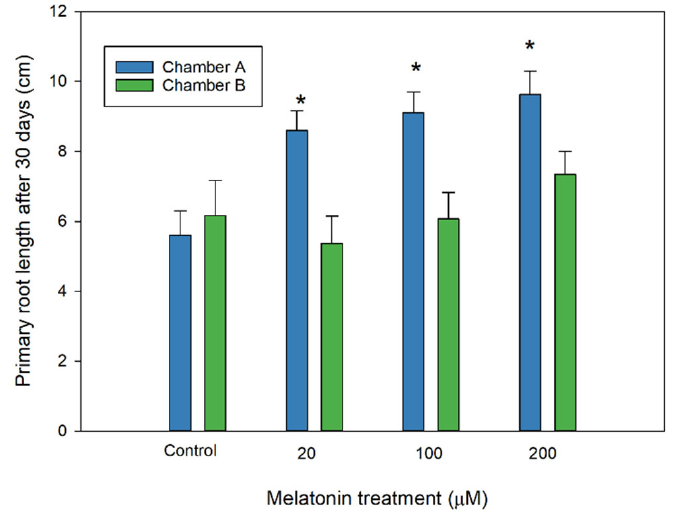
Figure 3. Effect of melatonin in almond primary root length of primed seeds after 30 days in chamber A and B (see Table 1). Each bar represents the mean value ( n = 36) ± SE obtained for each concentration used of three repeated experiments. Asterisks indicate significant differences with the control by each treatment based on a Duncan test with a significance level of p < 0.05.